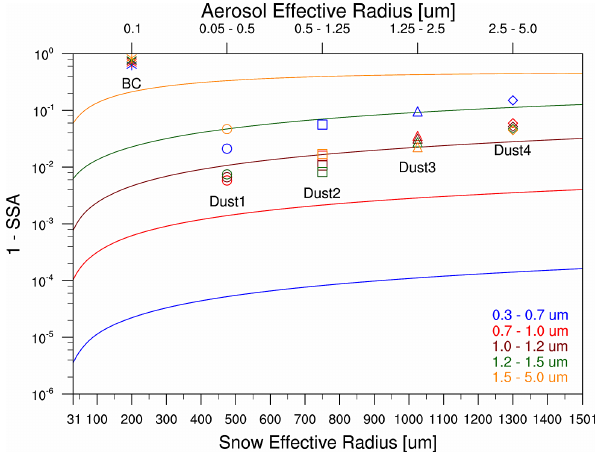
Figure 11. Single scattering co-albedo (1-SSA) at the five spectral wavebands of snow grains as a function of effective radius (colored solid lines), BC with an effective radius of 0.1µm (asterisk), and dust with four different sizes (Dust1: circle, Dust2: square, Dust3: triangle, and Dust4: